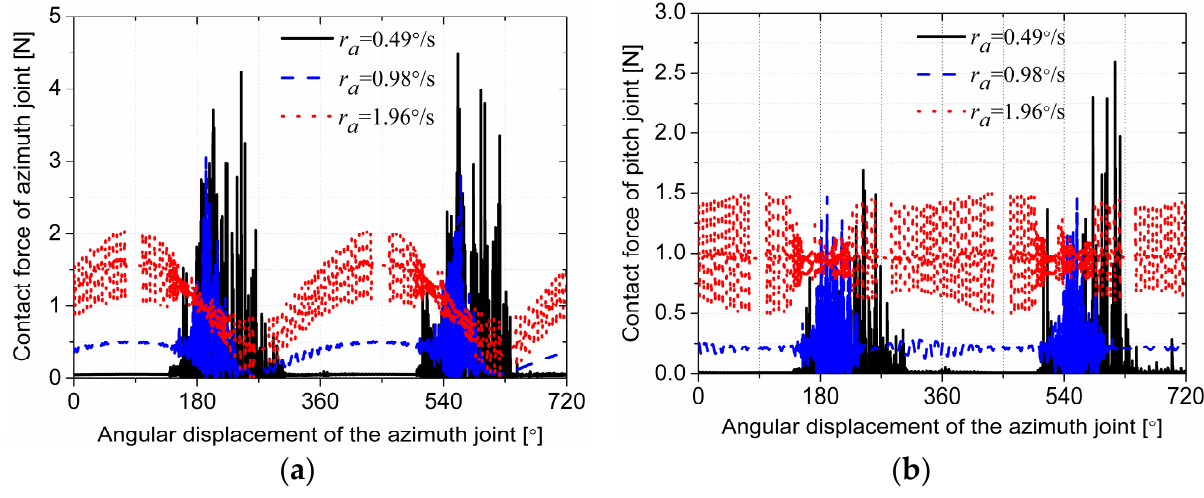
Figure 5. Radial contact force with a different rotational speed of azimuth joint—( a ) radial contact force of azimuth joint output side and ( b ) radial contact force of pitch joint output side.